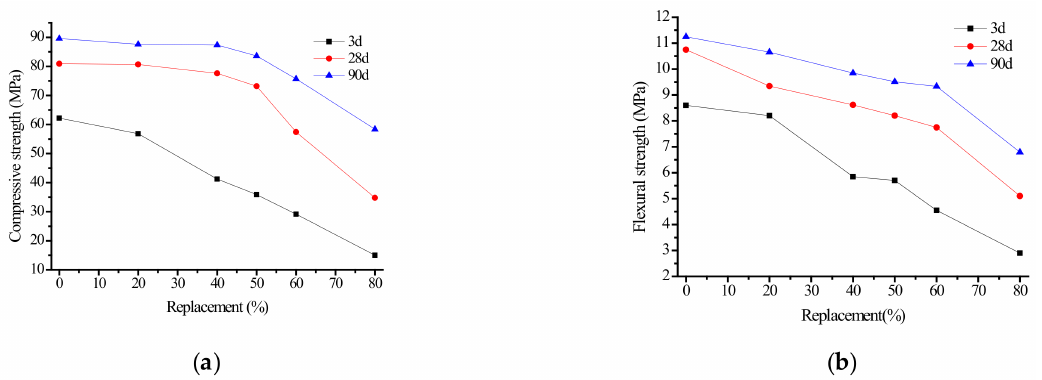
Figure 3. Effect of fly ash content on strength of alkali slag cement mortar. ( a ) Compressive strength, ( b ) Flexural